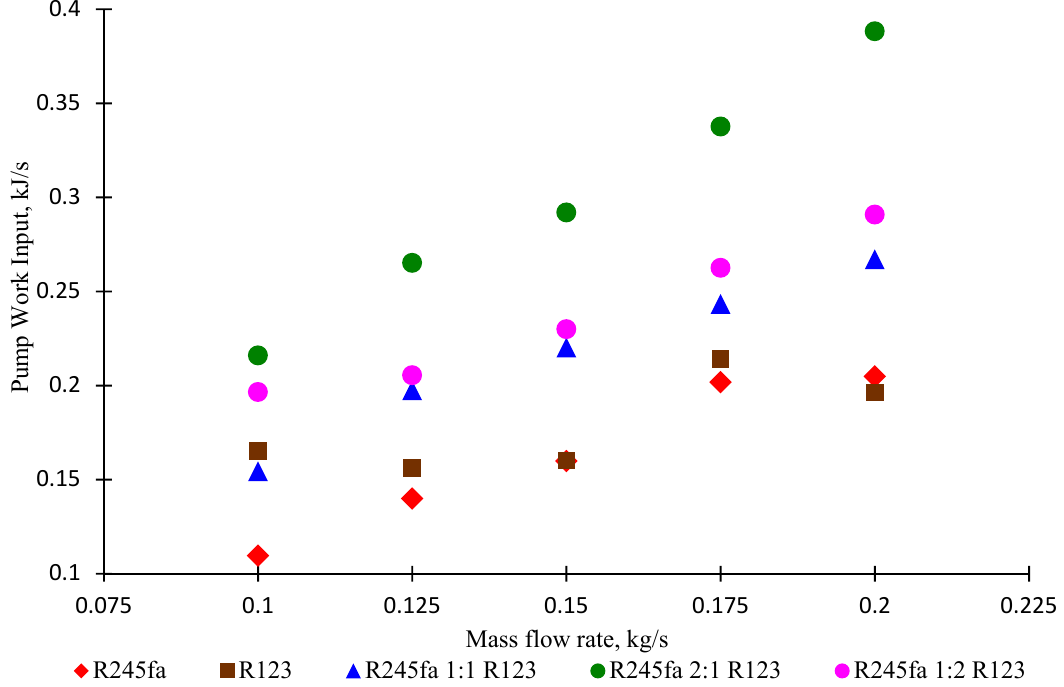
Figure 9. Pump work input as a function of mass flow rate for R245fa, R123, and mixed working fluids with heat source 110 ° C.